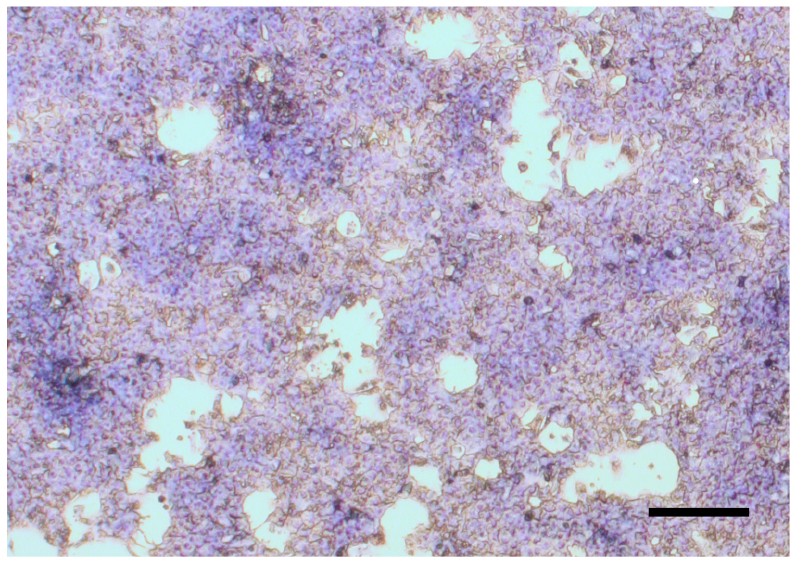
Figure 1. Giemsa staining of hepatocyte–non-parenchymal cell co-cultures after 24 h culturing (bar = 200 µm). (bar = 200 µ